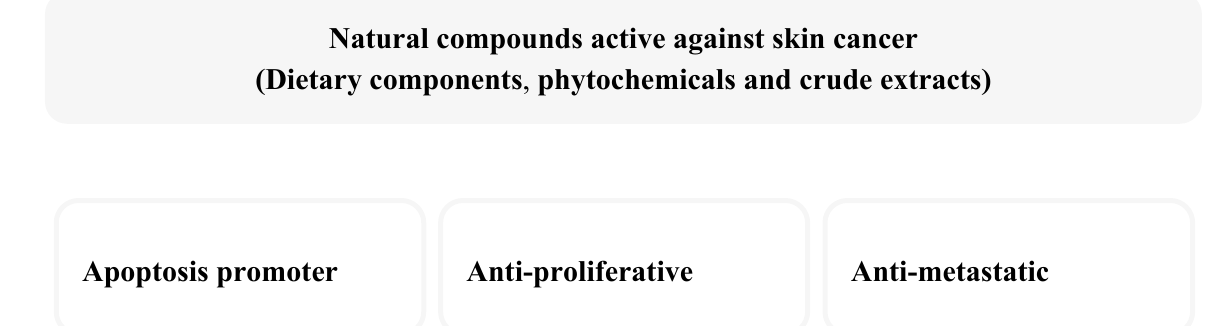
Figure 1. A scheme showing the anti-melanoma actions of the compounds and extracts discussed in this